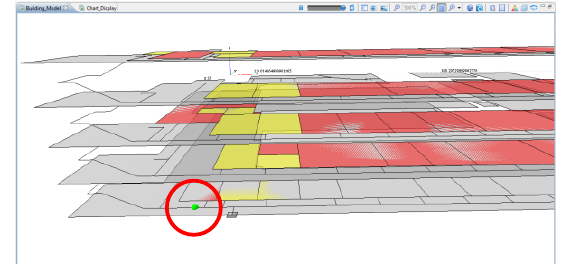
Figure 11. INDOOR_PATHS segment where PEOPLE agents get stuck during several simulation